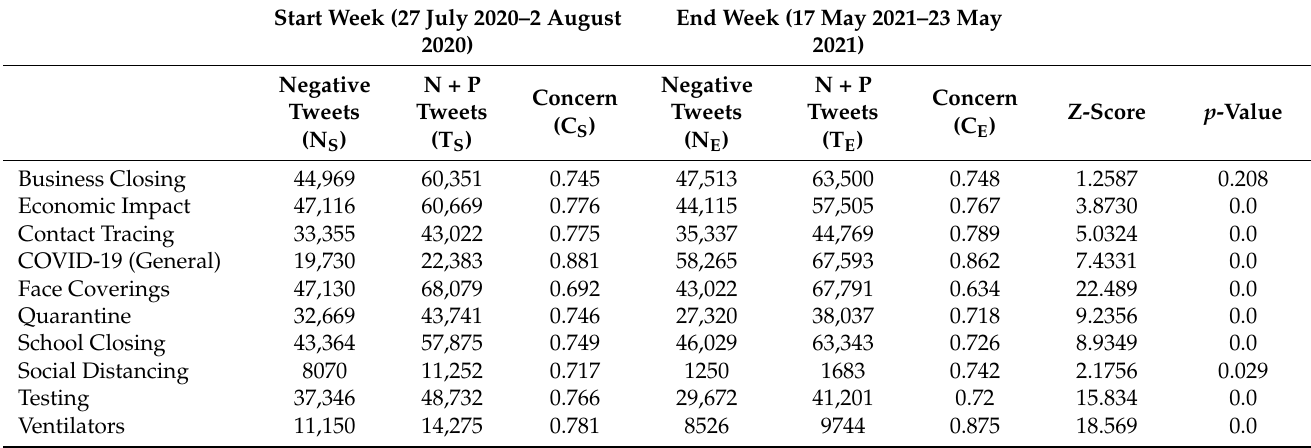
Table 4. Statistical Significance